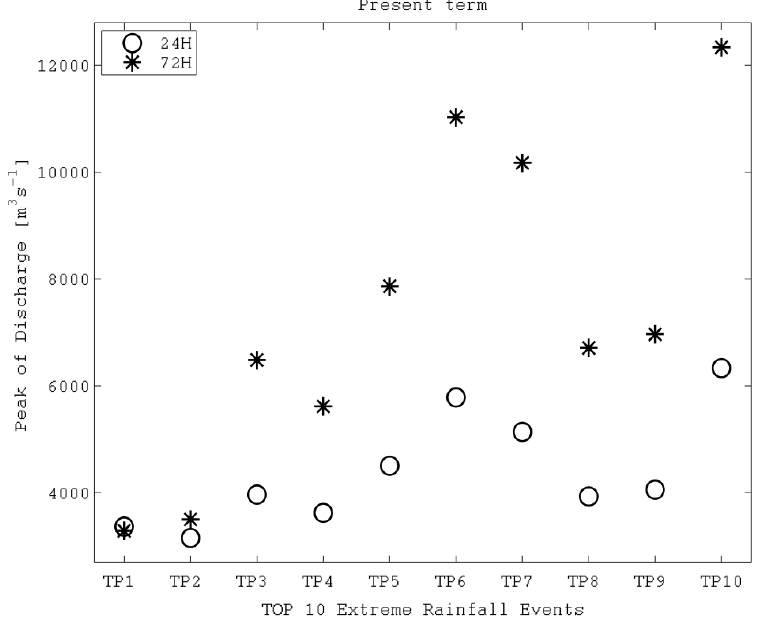
Figure 8. Present-term temporal distribution of normalized rainfall, averaged over the upper stream area from the dam inlet, from TP 1 to TP 10 for ( a ) 24-h; and ( b ) 72-h periods with the modified ranking method